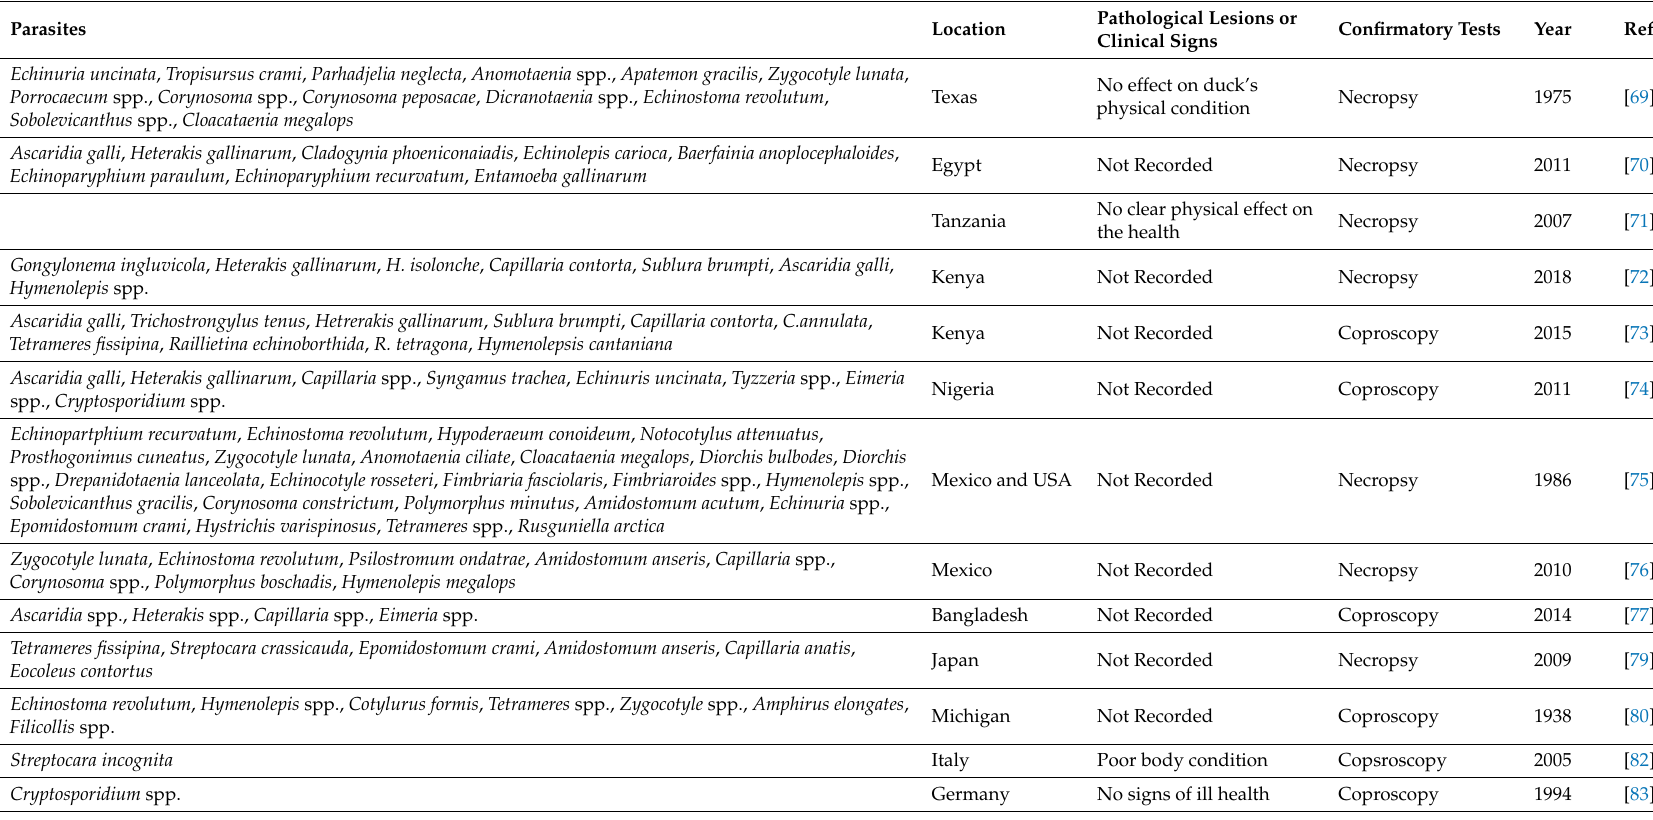
Table 6. Gastrointestinal Parasites present in ducks and its effect on the